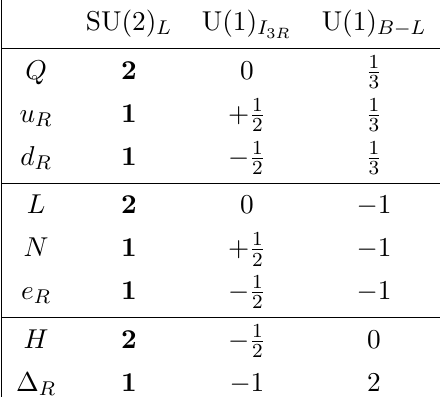
(cid:2) U(1) B (cid:0) L 3 R